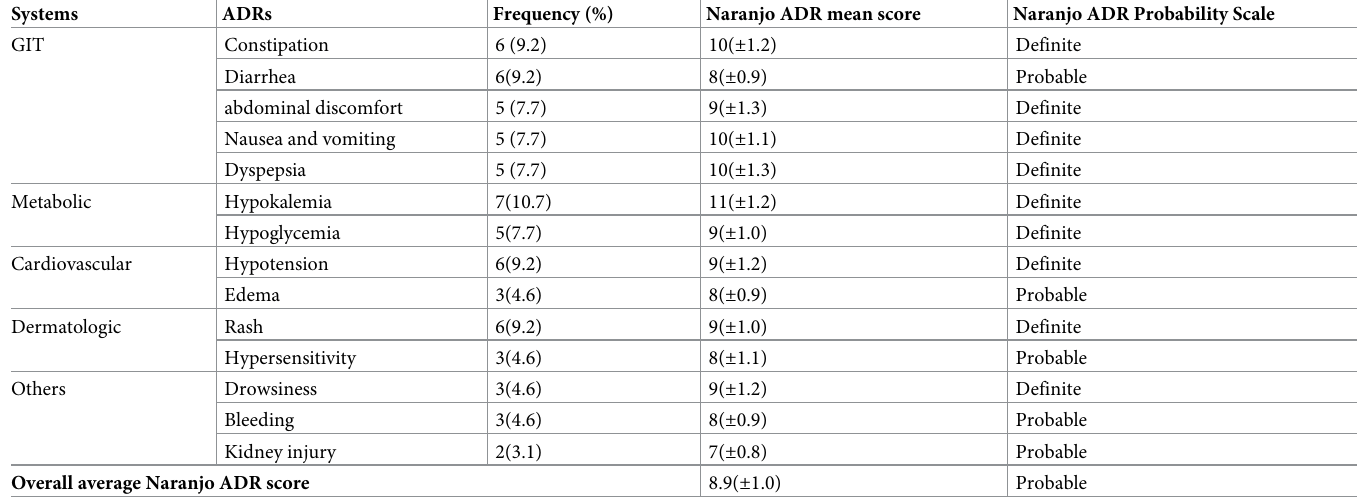
Table 5. Patterns of adverse reactions and their Naranjo ADR probability scale among hospitalized patients in the UoGCSH medical ward from May 28 to July 26, 2022 (N = 65). Systems